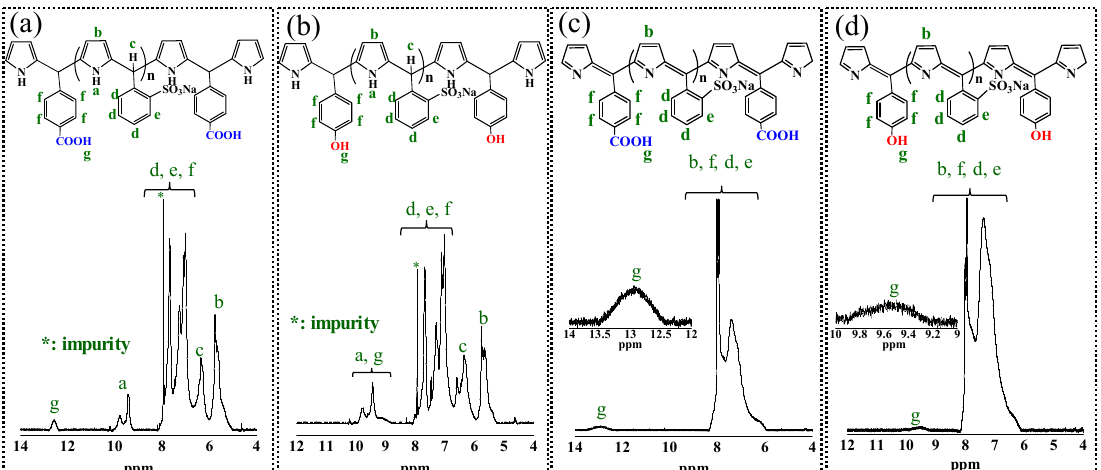
Scheme 1. Synthetic routes of narrow-band-gap polymers.